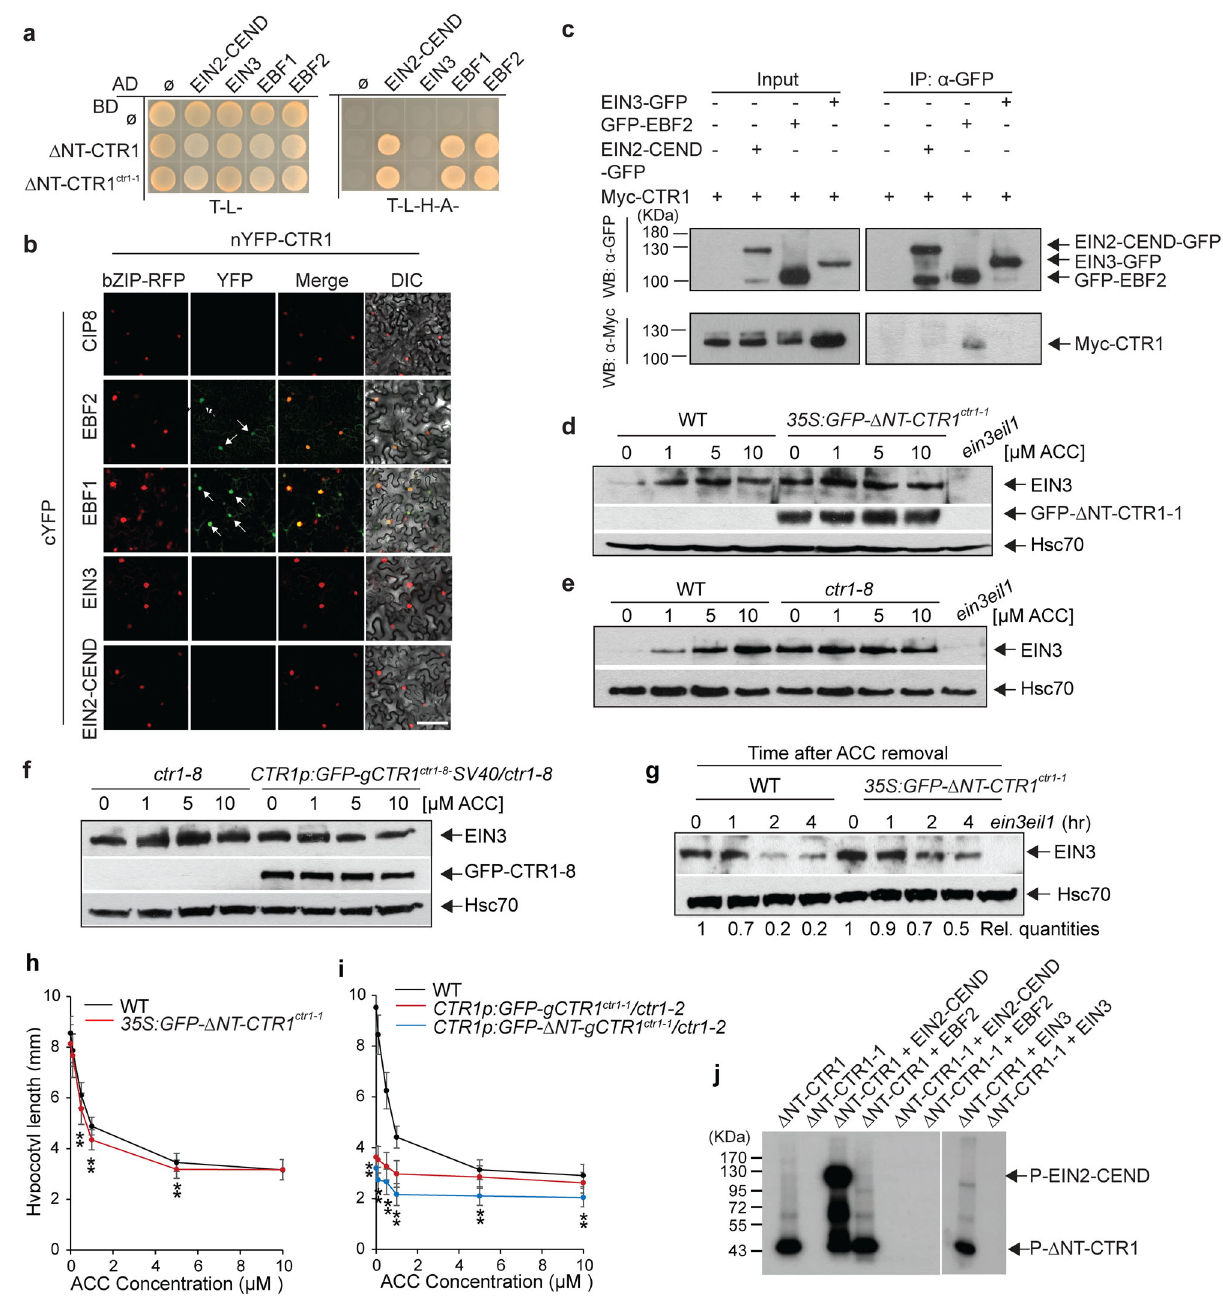
Fig. 5 | Nuclear-localized CTR1 stabilizes EIN3 via a non-catalytic function. a CTR1 interacts with EBF1 and EBF2, but not EIN3 in yeast-two-hybrid assays. b BiFCassayforfull-lengthwild-typeCTR1andnuclearethylenesignalingproteins in N. benthamiana in the presence of ACC. COP1-interacting protein 8 (CIP8) and bZIP-RFP were used as a negative control and a nuclear subcellular marker, respectively. c Co-immunoprecipitation analysis of CTR1 and EBF2 in N. ben- thamiana . d Three-day-old dark-grown seedlings were treated with the indicated concentrations of ACC for 2h, and total protein extracts were used for immuno- blotting with anti-EIN3, GFP, and Hsc70 antibodies. e , f ctr1-8 ( e ) and seedlings expressing GFP-CTR1-8-SV40 NLS in the ctr1-8 mutant ( f ) expressed higher basal levels of EIN3 than wild-type seedlings. The experiments were repeated at least three times with similar results. g 35S:GFP- Δ NT-gCTR1 ctr1-1 expressed a signi fi cantly higher level of EIN3 protein than the wild type after removal of ACC. Seedlings pretreated with 200 µ M ACC for 2h and total protein extracts were harvested at the indicated times after ACC removal. Rel. quantities represent the ratio of the